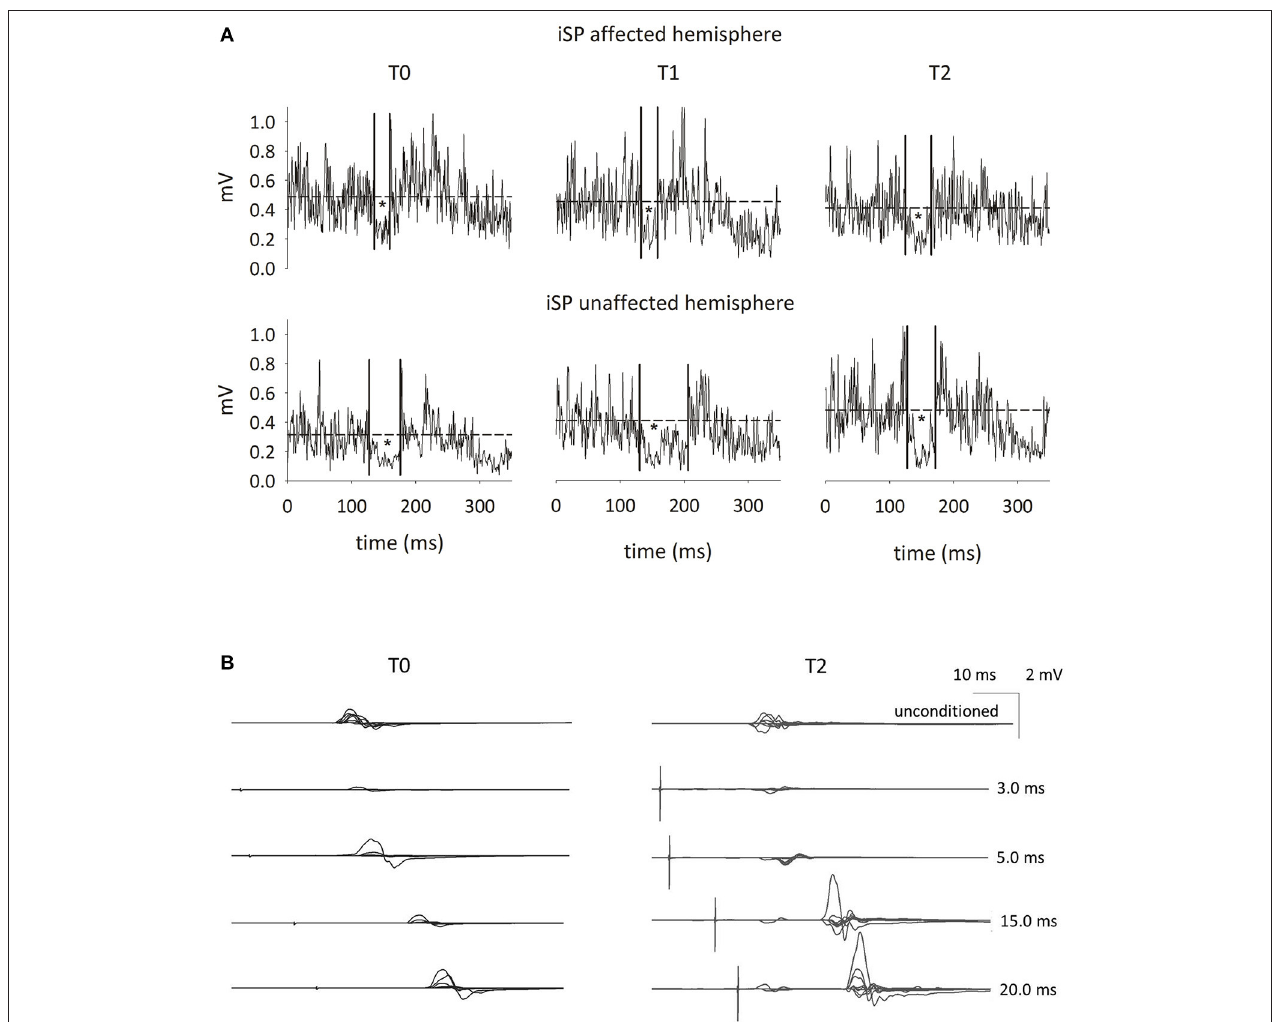
FIGURE 3 | Assessment of motor cortex excitability. (A) Shows the ipsilateral silent period (iSP) from TMS suprathreshold stimulation of M1 (120% of resting motor threshold, rMT) of either hemisphere at three time points: 40 days after the right thalamic stroke (T0), immediately after the last rTMS treatment on the primary motor area of the affected hemisphere (T1), and one month after the last rTMS (T2). Surface EMG from the first dorsal interosseous during maximal thumb adduction, rectified, filtered, and averaged across eight stimuli. Dotted lines indicate the mean amplitude of EMG activity in the 10ms preceding the TMS stimulus. The iSP area is marked with an asterisk (*). See Supplementary Material for further details. (B) Shows the short interval intracortical inhibition (SICI) and the intracortical facilitation (ICF) at T0 (left column of tracings) and T2 (right column) of the affected hemisphere. From top to bottom: eight superimposed traces of EMG signals were recorded after a single-pulse TMS delivered at 120% of the resting motor threshold (rMT) (line 1: unconditioned), and after paired-pulse TMS (ppTMS; lines 2–5). For ppTMS, the conditioning stimulus was given at 75% of rMT 3ms (line 2), 5ms (line 3), 15ms (line 4), and 20ms (line 5) before the conditioned stimulus, delivered at 120% of the